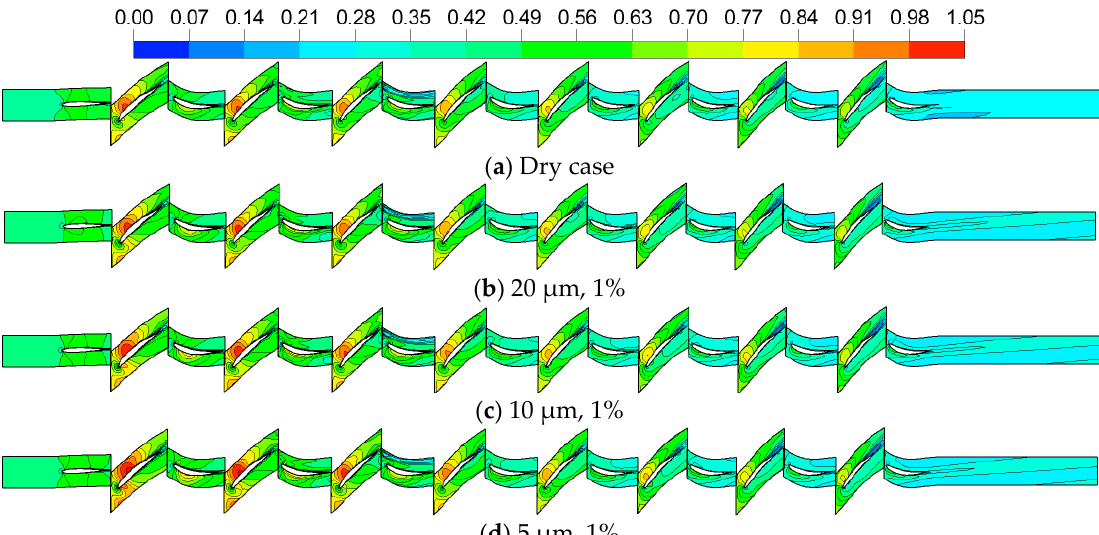
Figure 21. Mach Number contours of 50% span on the blade to blade surface under injecting water of different droplet sizes.